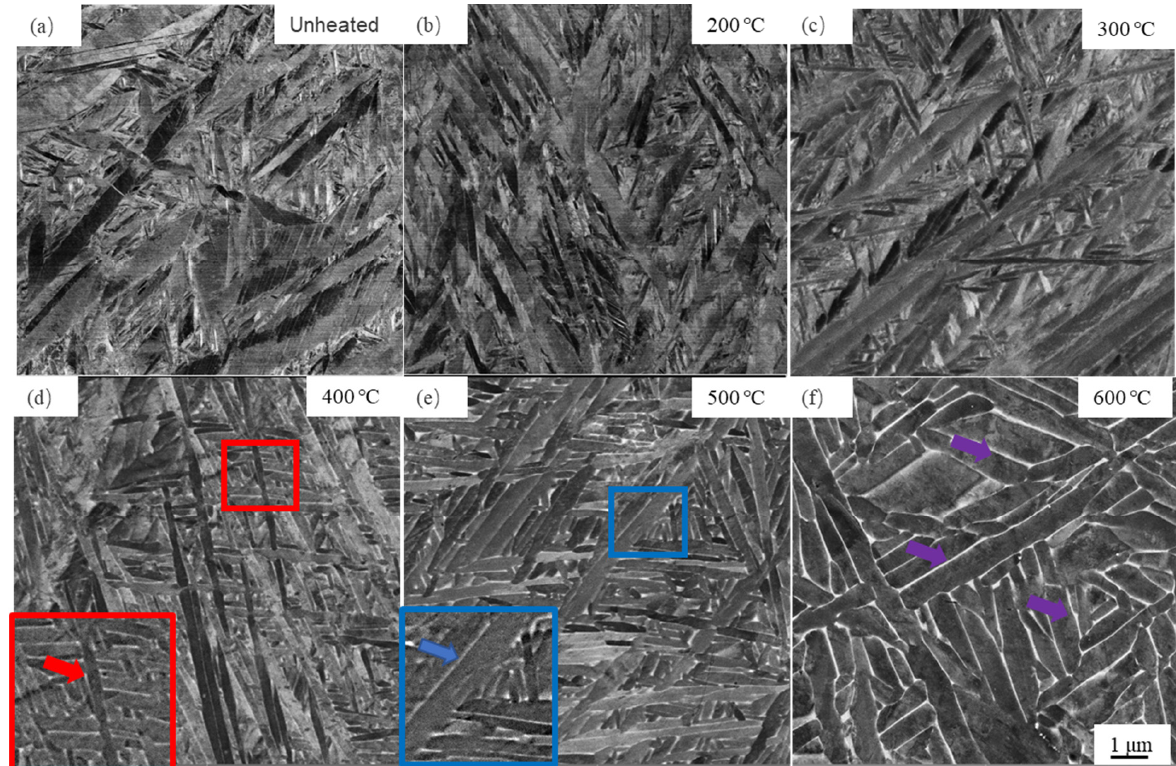
Figure 5. BSE micrographs of the Ti-6Al-4V alloy produced by LPBF in the case of ( a ) unheated, ( b ) 200 °C, ( c ) 300 °C, ( d ) 400 °C, ( e ) 500 °C, and ( f ) 600 °C. Table 3. Element content in the intragranular β phase of Figure 5d–f. Element Content,